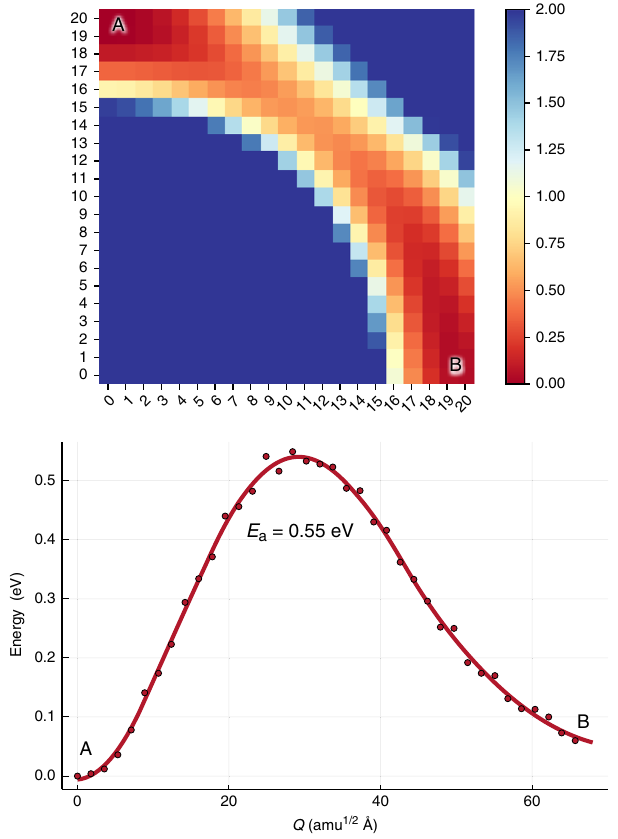
Fig. 7 First-principles analysis of the activation energy for hopping. a Calculated 2D energy surface on a 20 × 20 real-space grid for V þ migration in a (001) plane of tetragonal MAPbI 3 from initial state A to fi nal state B along the con fi gurational coordinate Q. b The projected 1D pathway showing the associated activation